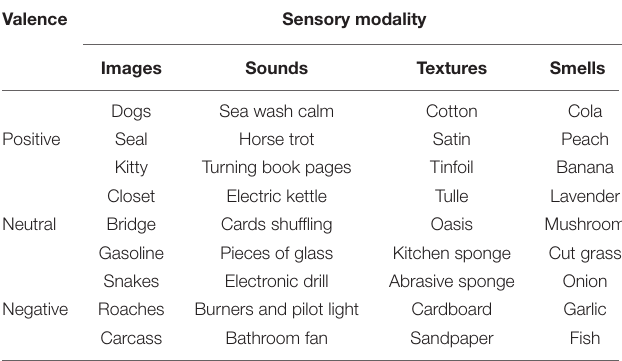
TABLE 1 | Test stimuli across each sensory